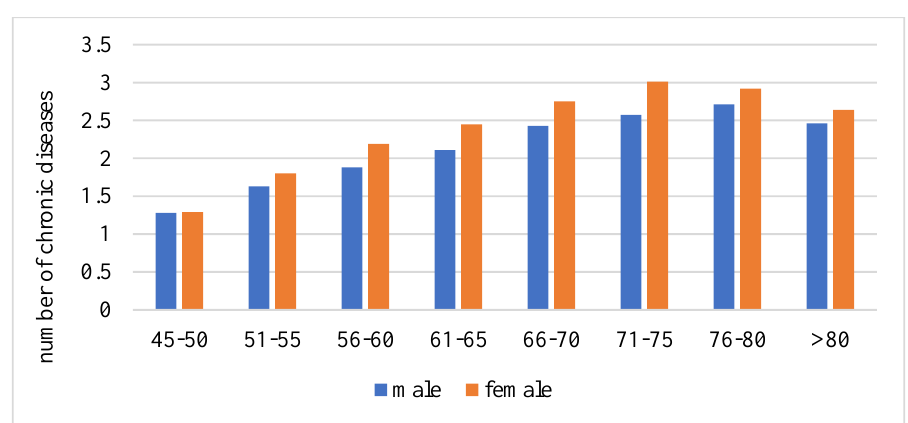
Figure 2. Number of chronic diseases by age and gender.